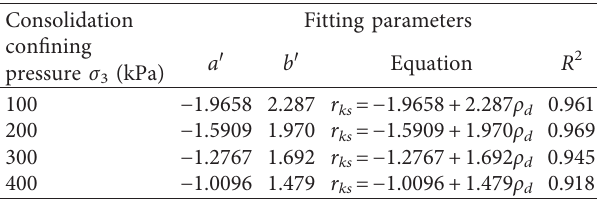
Table 10: Linear fitting parameters under K Consolidation